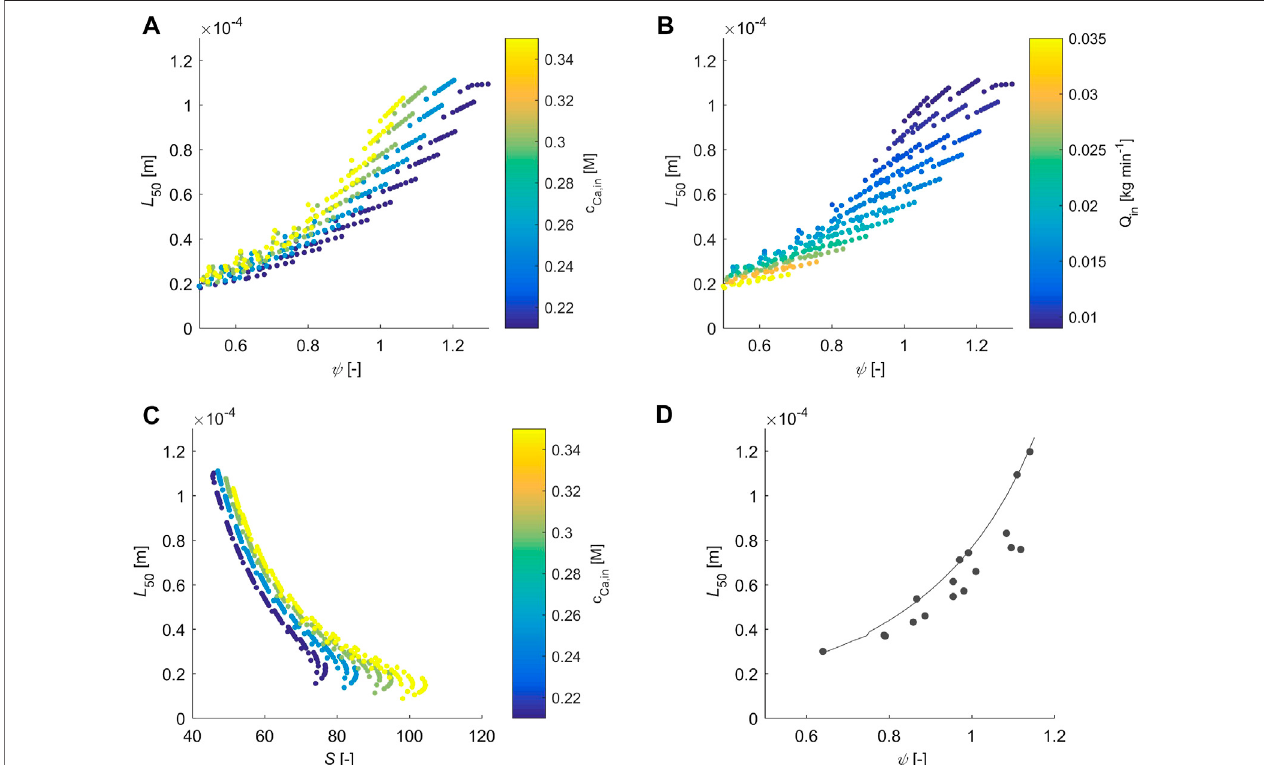
FIGURE6| L 50 isplottedover Ψ andS.The fi lledcirlesinsubplota-ccorrespondtosimulatedpoints,whereasthecolorrepresentsthequantityspeci fi edinthewith thecolorbar.Subplotdshowsexperimentalresults(greycircles)andmodellingresults(solidline),whichwasobtainedby fi xingthegasinlet fl owrateto18.5mmolmin -1 , the calcium concentration of the feed to 0.3 molal and by varying the liquid feed